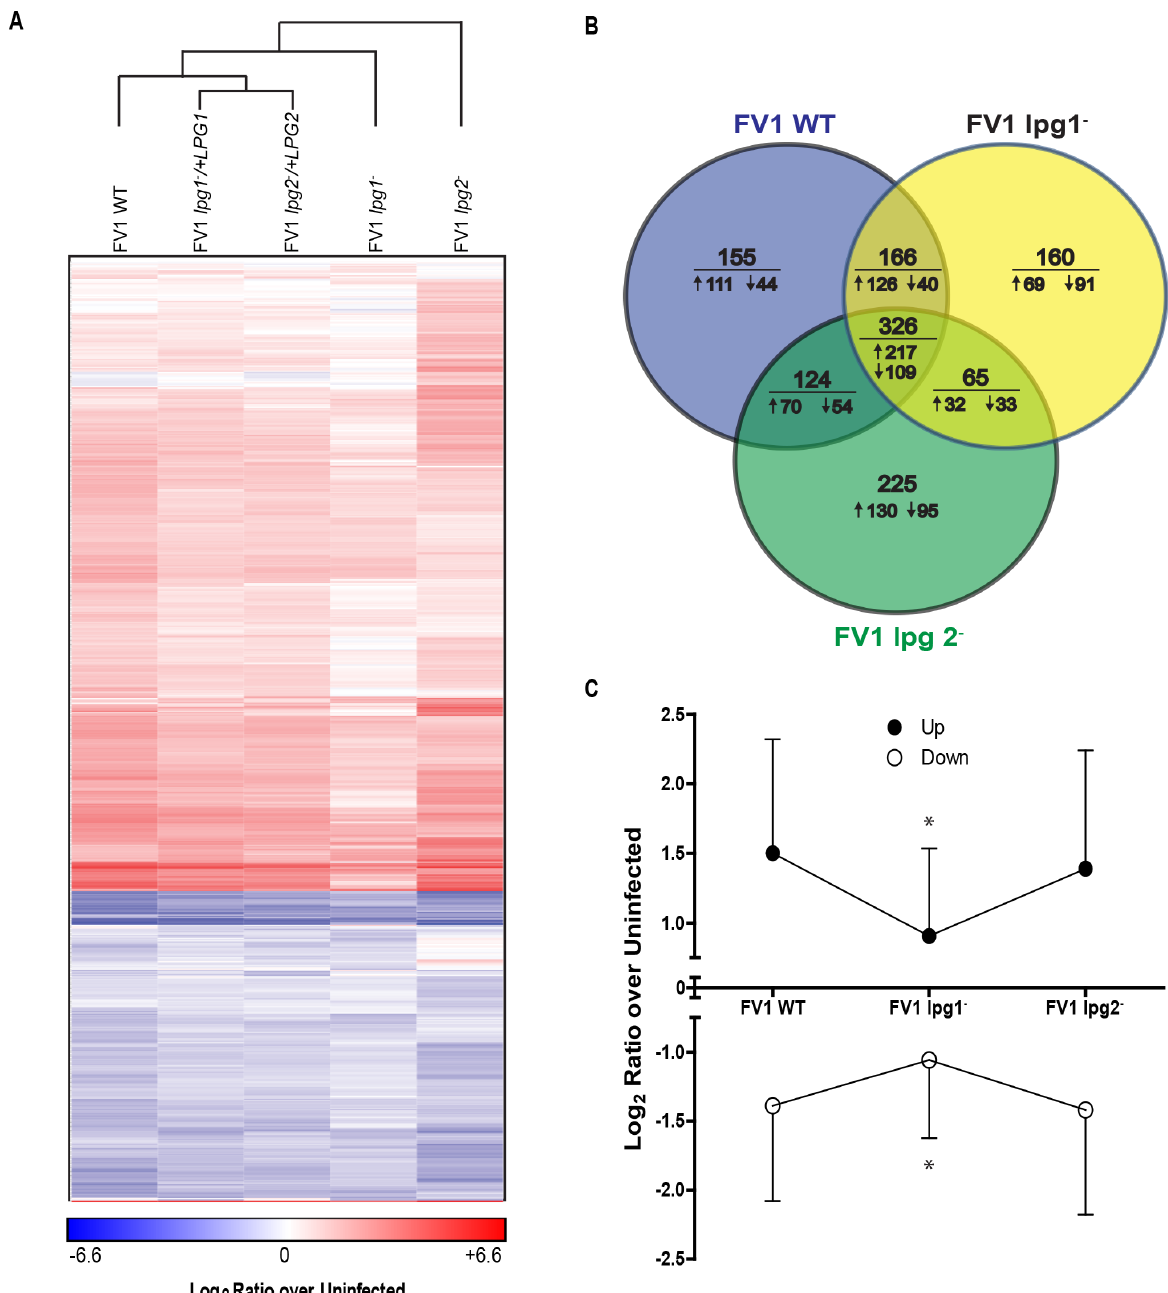
Fig 5. Leishmania major human host dendritic cells gene expression profiles. (A) Gene transcript expression heat map of in vitro infected monocyte- derived hDCs. The color scale is based on average log 2 ratios of RMA-normalized microarray gene probe set values for variably infected host cells over uninfected cells. Only the genes that displayed significant differential expression by z-ratios, from both uninfected samples and between infections with FV1 WT and FV1 lpg1 − or FV1 lpg2 − mutants or their respective add back strains, were included in the map. Genes and sample types were clustered by city block distance metric using average linkage in GENE-E. (B) Venn diagrams with the number of host DC genes significantly differentially expressed from uninfected samples in FV1 WT, FV1 lpg1 − , and FV1 lpg2 − mutants as quantified by microarrays. Values below the horizontal line indicate the number of genes from the above total that were up- ( " ) or down-regulated ( # ) compared to uninfected samples. (C) Total average log 2 ratios of up- and down-regulated genes significantly differentially expressed from uninfected samples in FV1 WT, FV1 lpg1 − , and FV1 lpg2 − mutants as quantified by microarrays, plus or minus standard deviation. * Significant difference of log 2 ratio values (p < 0.05) between FV1 lpg1 − infected DCs compared to FV1 WT and FV1 lpg2 − infected DCs by ANOVA with Bonferroni multiple comparisons